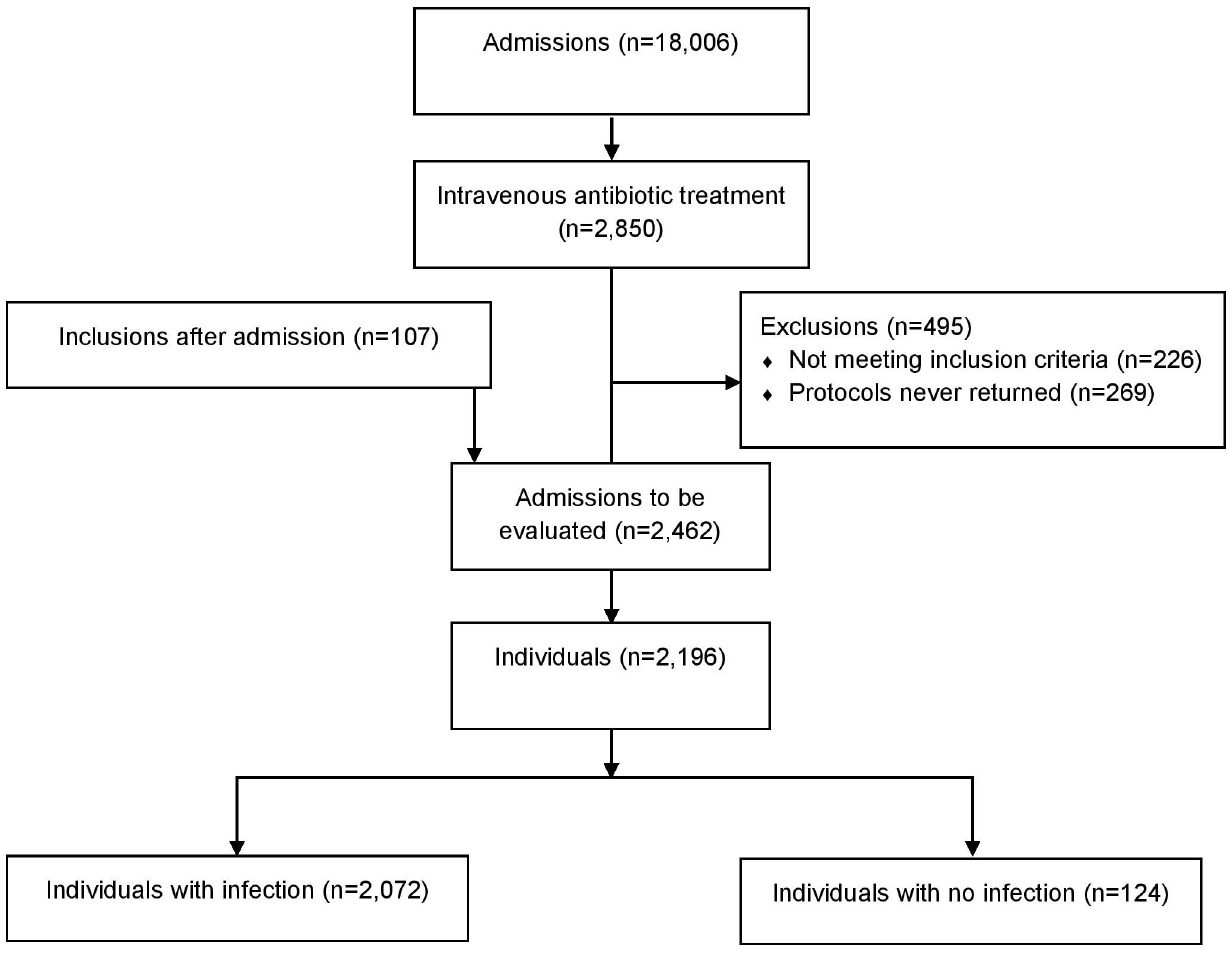
Fig 1. Patient selection flowchart for the present